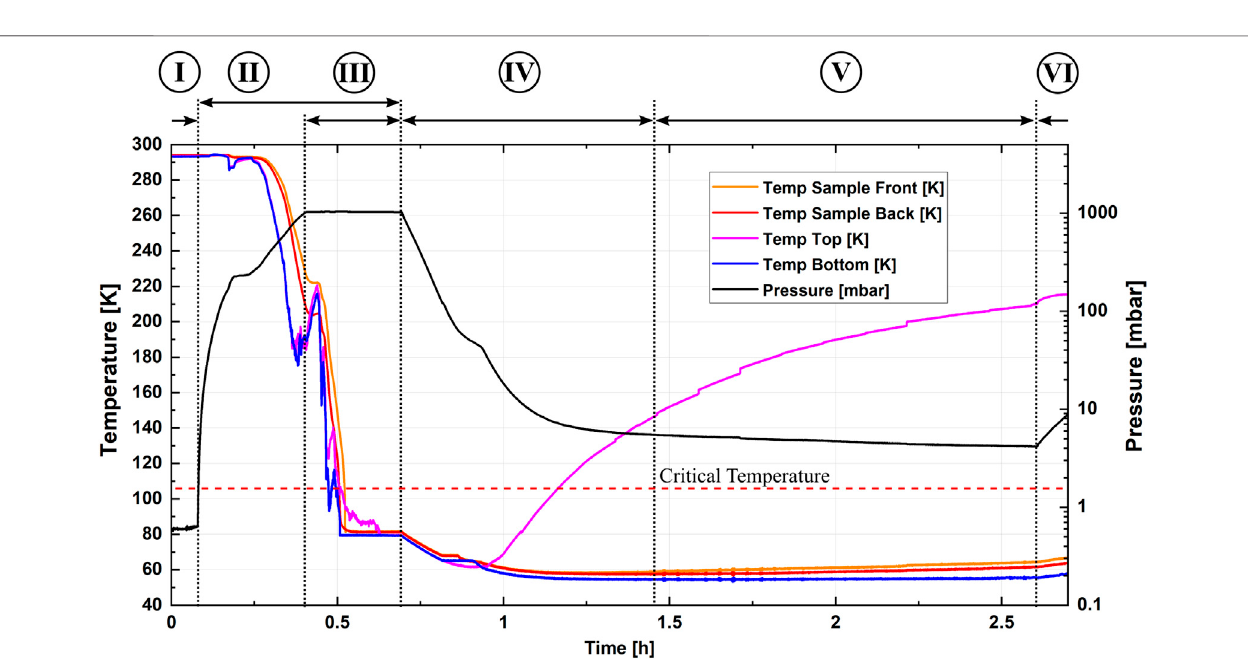
FIGURE6| Temperaturesinsidethecryo-boxthroughoutthecoolingprocessandthrustmeasurements.(I)Createvacuum.(II)Enablenitrogenevaporatorto fi llthe chamber with nitrogen gas. (III) Cooling procedure of the setup and reservoir fi lling with liquid nitrogen at > 125 mbar ambient pressure. (IV) Enable vacuum pump to further decrease N2 temperature and decrease convection for thrust measurements. (V) Thrust measurements at minimum temperature and chamber pressure with solid nitrogen. (VI) Measurement time-limit determined by the emptying nitrogen reservoir.